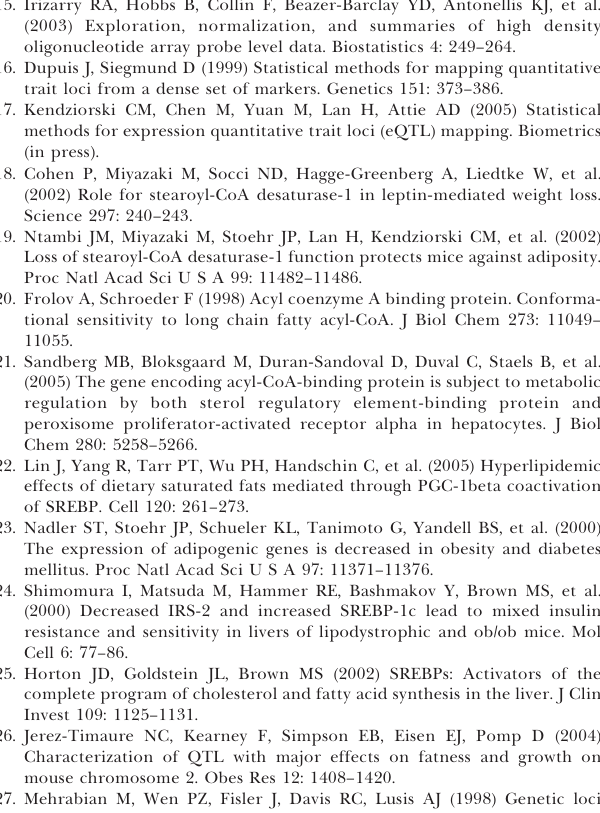
Table S3. GO Enrichments of Traits That Are Correlated with Seed Traits From the lists of traits correlated with the seed traits in Table S2, we identified 15,726 BP GO terms in total, among which 862 are unique. For each of the unique GO terms, we traced back the lists of correlated traits that were enriched ( P ¼ 0.01), and we concatenated all such lists. Columns A and B show the GO category identifiers and the names, respectively. Columns C and D show the probe set IDs and gene names of the correlated traits. Column E shows whether ( ‘‘ T ’’ or ‘‘ F ’’ ) the traits were annotated as belonging to the corresponding GO terms in the public database. Table S4. Descriptions of the 174 GPCR Protein Signaling Pathway Traits Columns A, B, and C show the Affymetrix probe set IDs, gene symbols, and gene titles of the 174 gene traits. Columns D and E show the physical chromosomes and positions (Mb) of the 174 traits. Columns F, G, and H show the chromosomes, positions (Mb), and LOD scores of the maximum LOD peaks of those 174 traits. Table S5. Top 100 Traits Whose Expression Levels Are Correlated with Those of Scd1 in the 60 F 2 Mice Column A shows the Affymetrix probe set IDs. Columns B and C show the gene symbols and the titles of the genes. Columns D and E show the genomic locations of these traits. Column F shows the Pearson correlation coefficients. Column G shows the unadjusted P- values for the correlations.